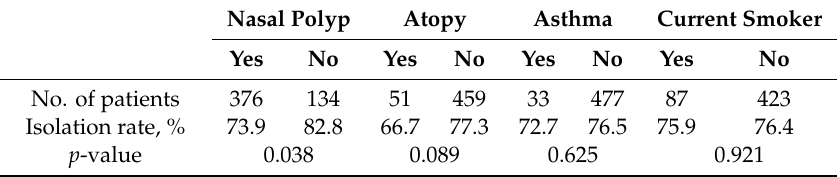
Table 2. Comparison of bacterial isolation rate according to the demographic data.